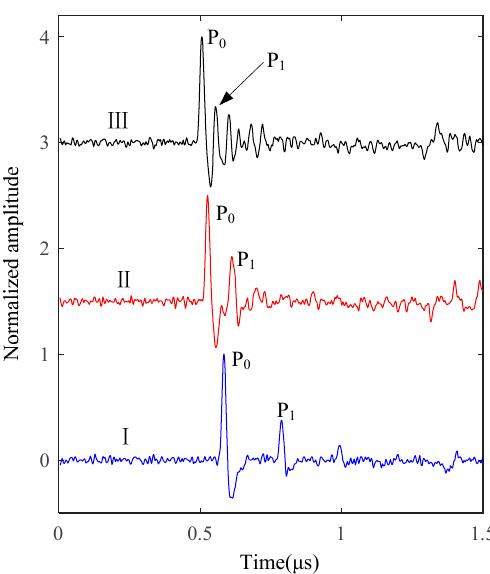
Figure 9. The signals collected by experiment. Table 3. The experimental data and calculated results.